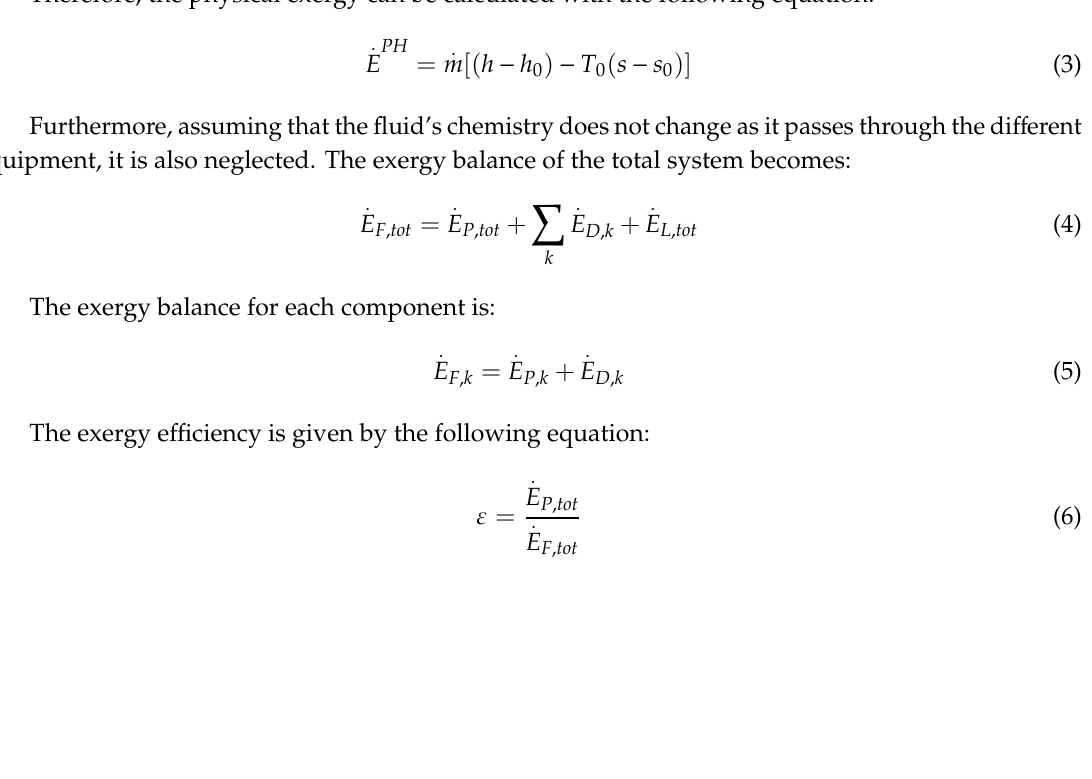
2 cycle with an ejector (model 4: ejector